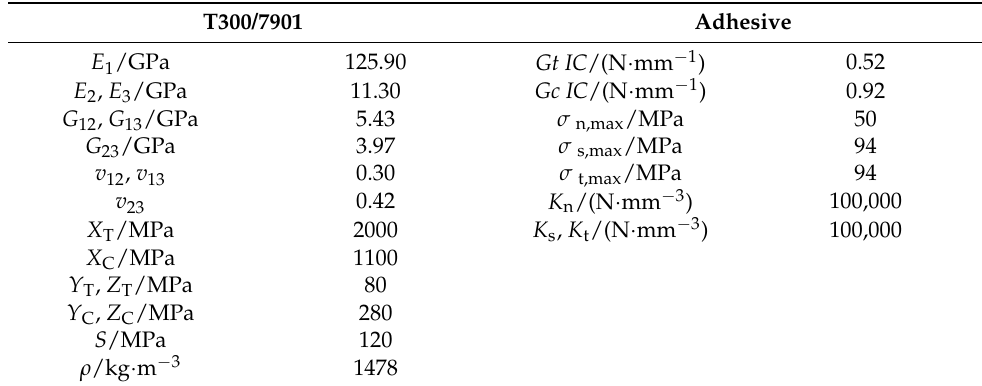
Table 1. Mechanical material properties of the CFRP laminates and adhesive.